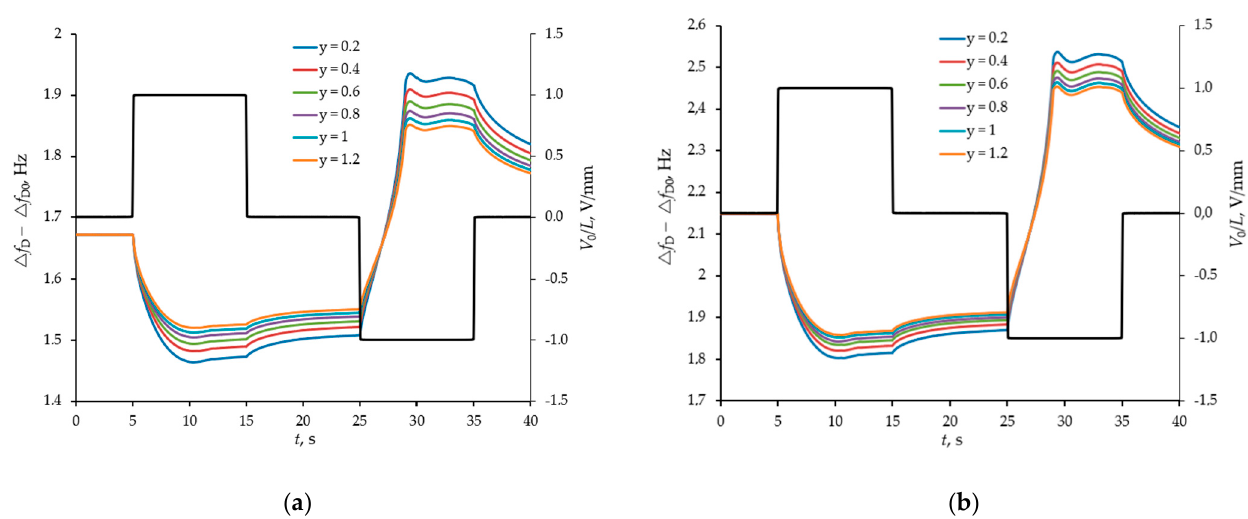
Figure 7. The difference response from two sensors (with smooth and structured surfaces) in the form of a shift of their resonance frequencies to manipulation of a model buffer solution with proteins by an external pulsed field at different ratios of oligomeric forms of uromodulin (y = [T&HE (28)]/[T&HE ( 7)], [T&HE (28)] + [T&HE (7)] = 120 mg/L) for a normal albumin level of 20 mg/L ( a ) and for its 3-fold increase ( b ). Frequency shifts (left axes) are shown with coloured curves, and pulse actions (right axes) are shown with a black broken line.